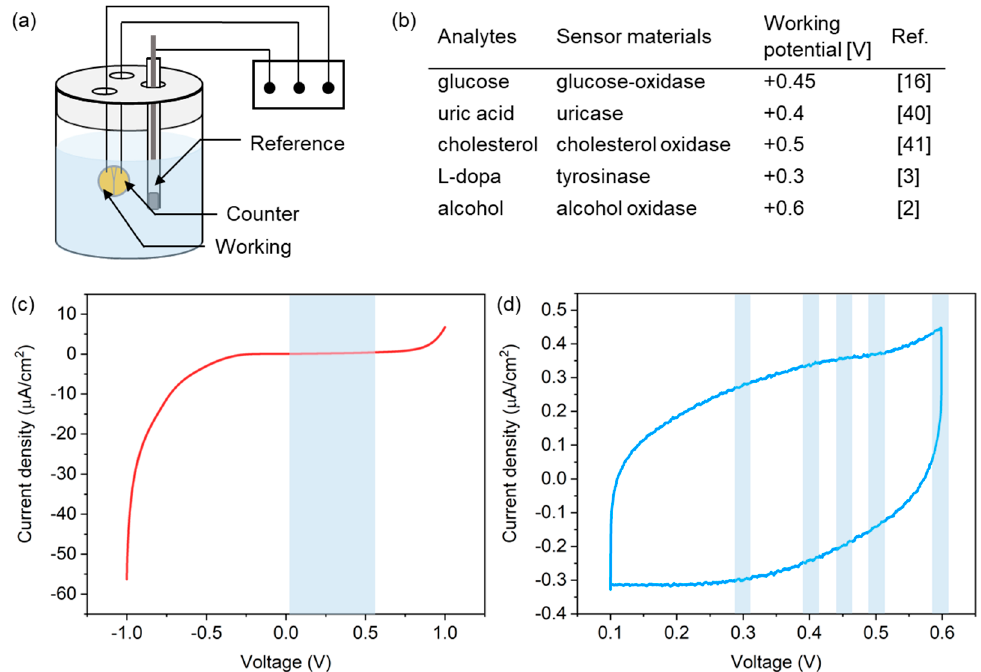
Figure 5. ( a ) Experimental setup used for LSV and CV measurements. ( b ) Working potentials of the redox reactions of several analytes. Current responses from the microneedle sensor in PBS solution during ( c ) LSV and ( d ) CV measurements in PBS.